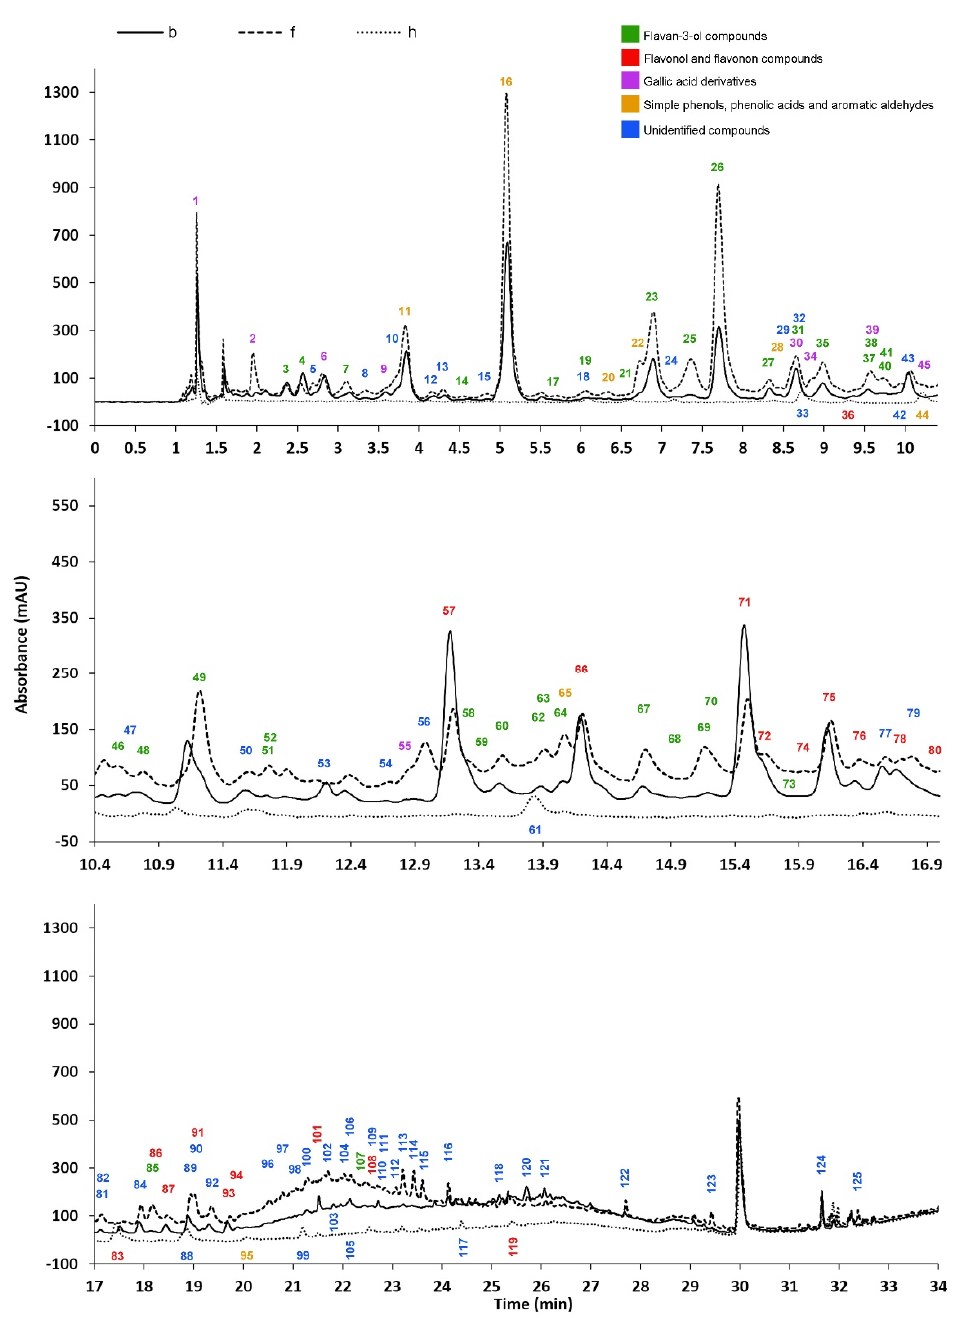
Figure 2. The typical HPLC PDA (250–300 nm) chromatograms of the b, f, and h beech wood tissue extracts.